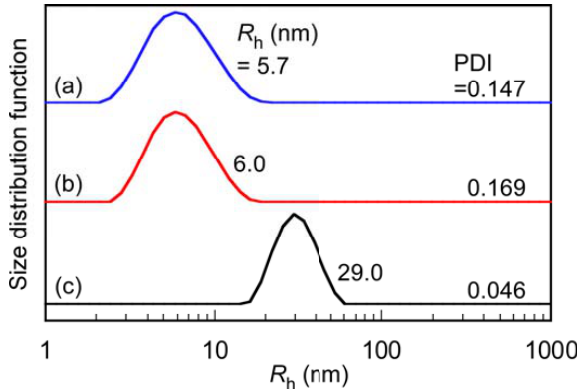
Figure 3. Hydrodynamic radius ( R h ) distributions with polydispersity indices (PDI) for ( a ) P(SA) 91 S 67 , ( b ) P(SA) 91 A 88 , and ( c ) PIC micelles in 0.1 M aqueous NaCl.